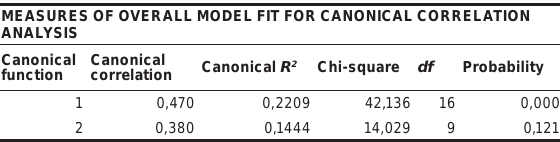
Table 10 Canonical correlation analysis for the CCQ lite domains and the MQ